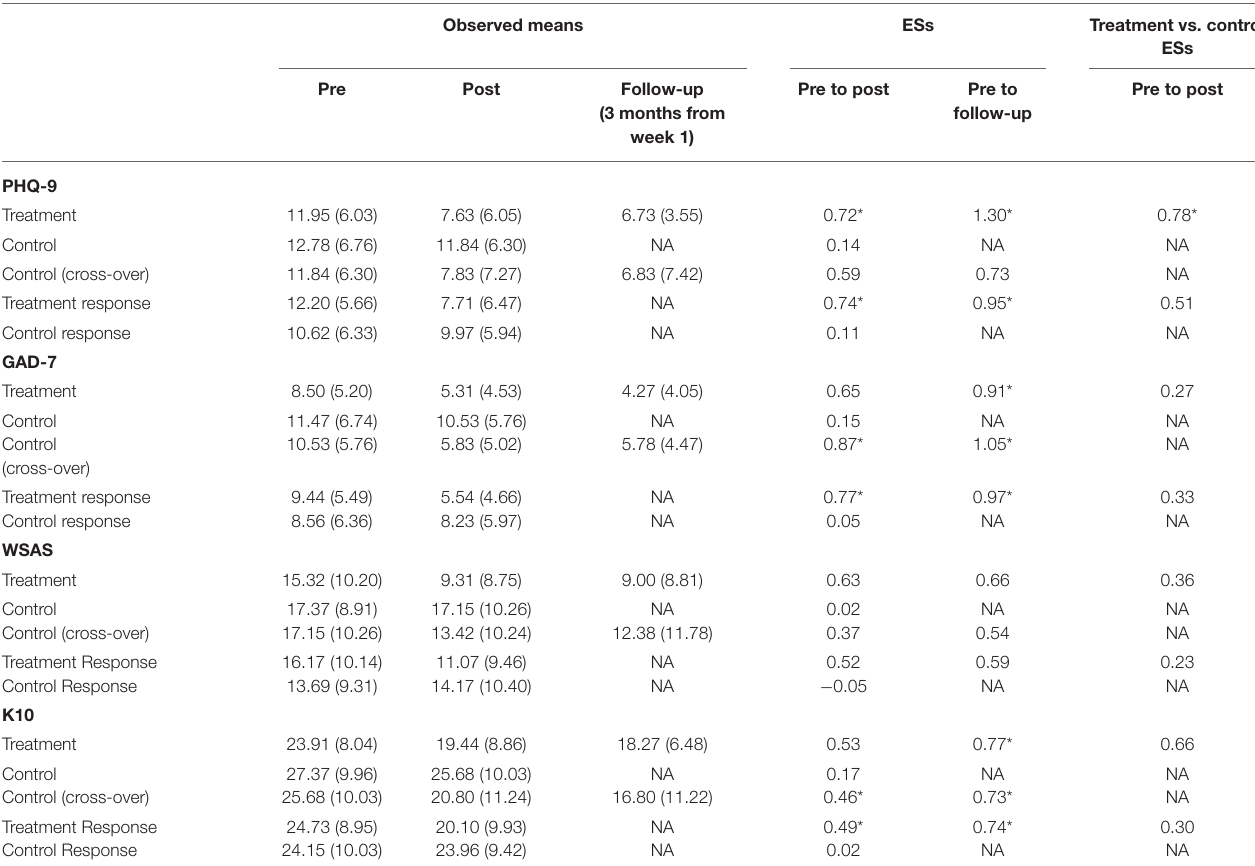
TABLE 2 | Observed and estimated means, standard deviations, ESs (Cohen’s d) for outcome measures.